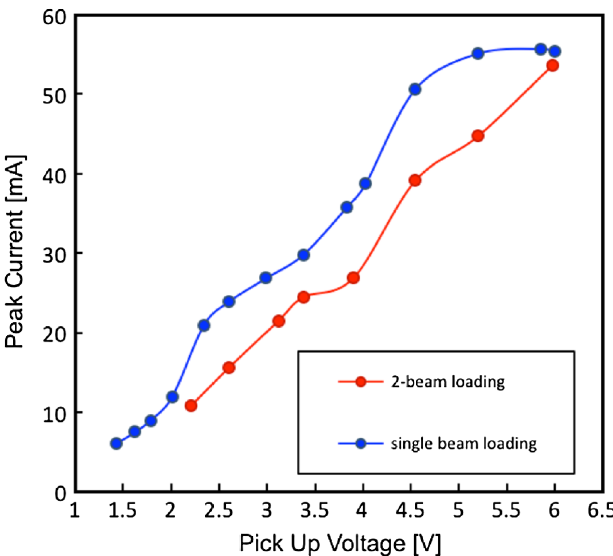
FIG. 39. Peak output current from channel 2 in single and two- beam loading (plasma input position: 6 mm; extraction voltage: 30 kV).